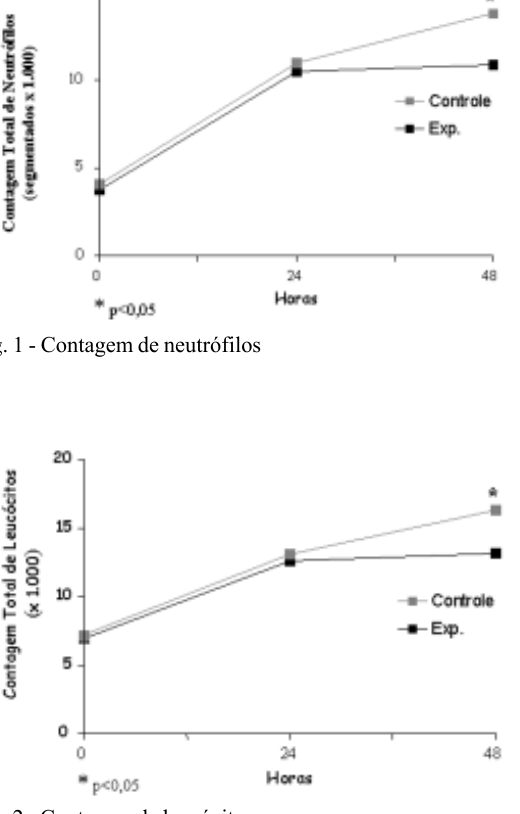
Fig. 2 - Contagem de leucócitos